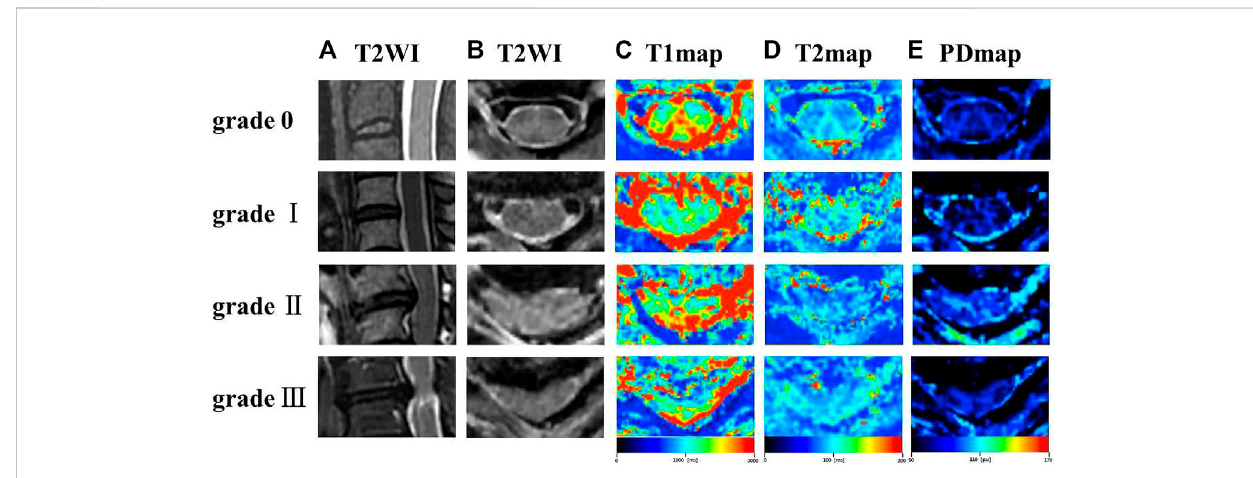
FIGURE 1 Representation sagittal T2WI (A) , axial T2WI (B) , T1 colormap (C) , T2 colormap (D) and PD colormap (E) of the spinal cord of at C2/3 intervertebral disc level in grade 0 group, and the spinal cord at the maximal compression level (MCL) in grade I-III